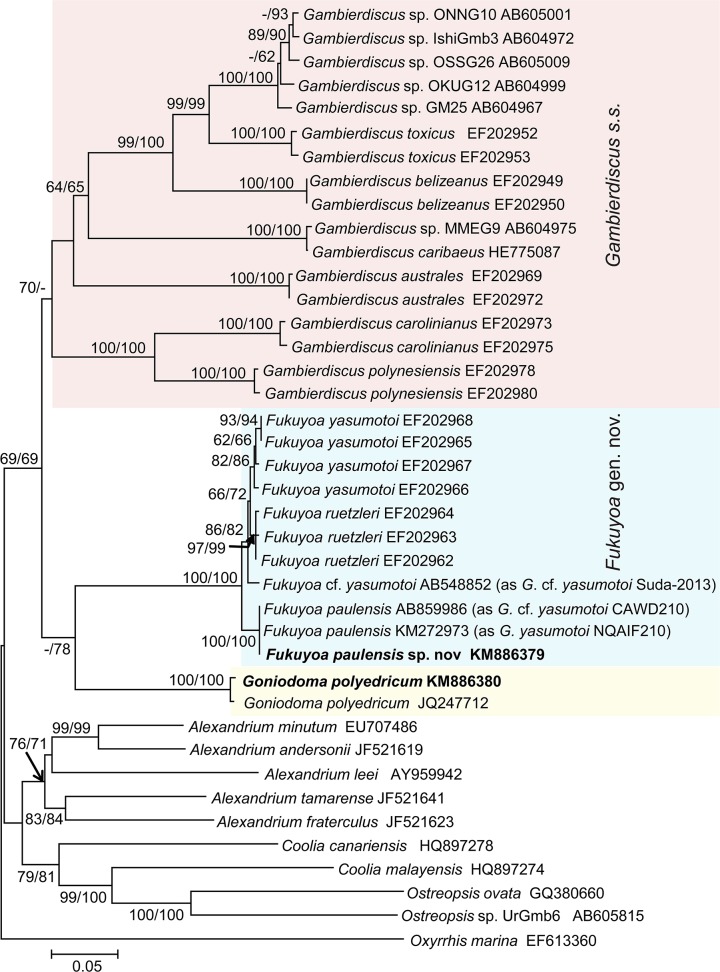
(D1-D3) LSU rDNA-based phylogeny of Fukuyoa paulensis gen. et sp. nov. and Goniodoma polyedricum with some gonyaulacoid dinoflagellates.Sequences obtained in this study are bold-typed. Support of nodes is based on bootstrap values of ML/NJ with 1000 and 500 resamplings, respectively. Only values greater than 60 are shown. Oxyrrhis marina was used as outgroup.